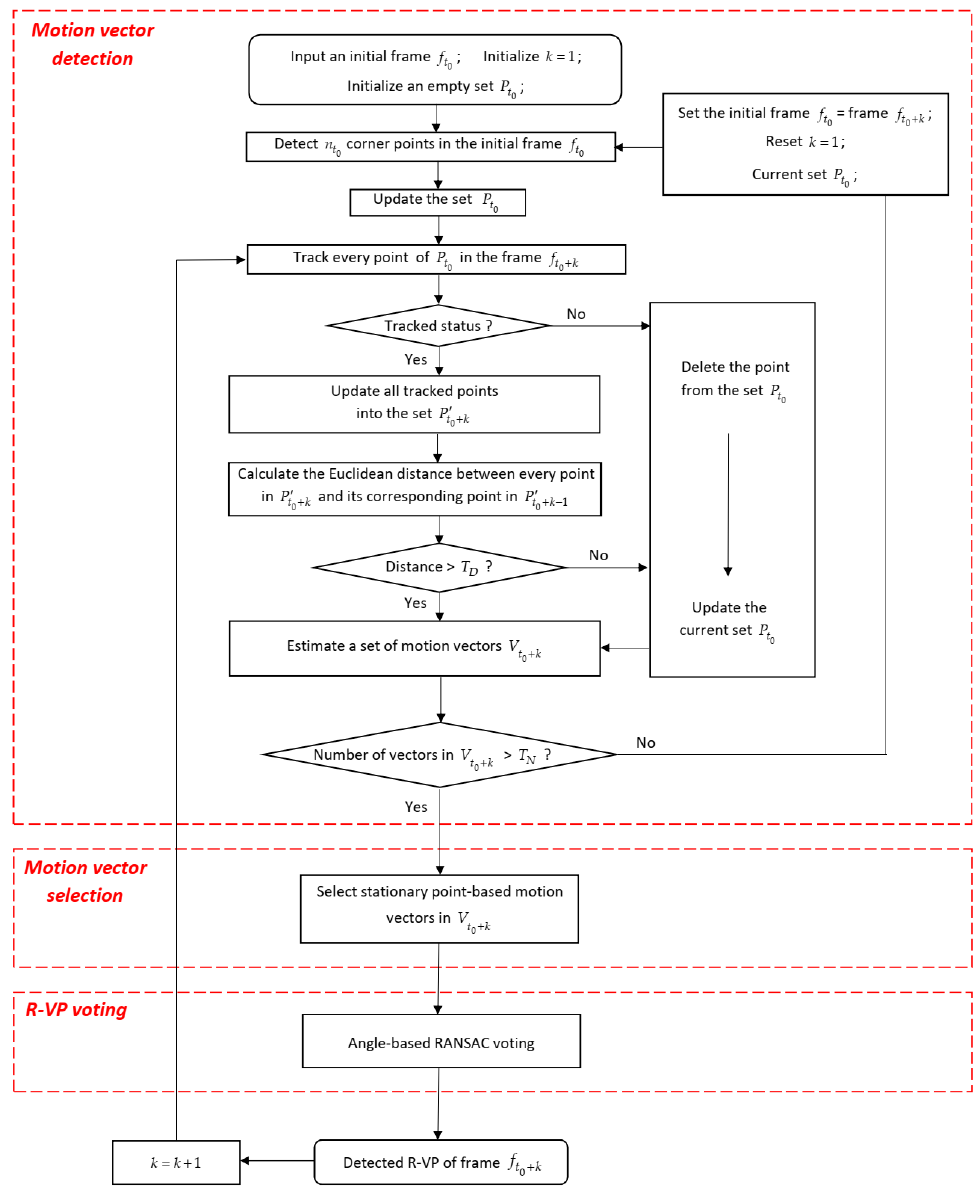
Figure 3. Flowchart of the proposed R-VP detection method.